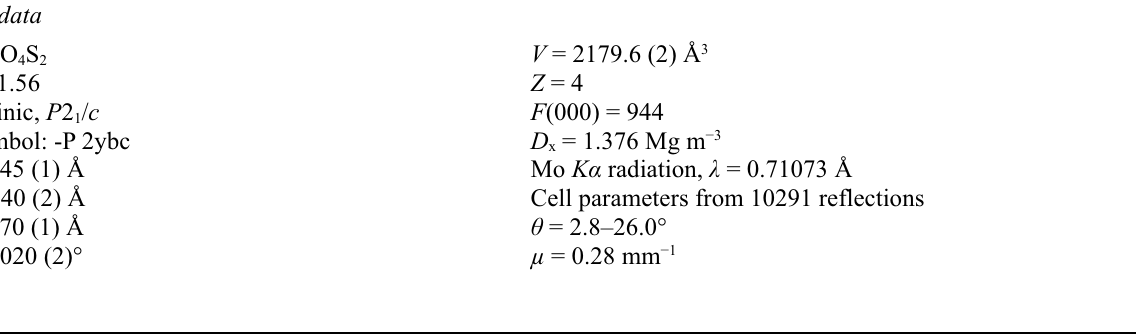
The molecular structure of (I), with atom labeling scheme. Displacement ellipsoids are drawn at 50% probability level. H atoms are presented as a small spheres of arbitrary radius. Intramolecular H-bonds are shown as dotted lines. Ethyl 2-[(phenylsulfanyl)methyl]-1-(phenylsulfonyl)-1 H -indole-